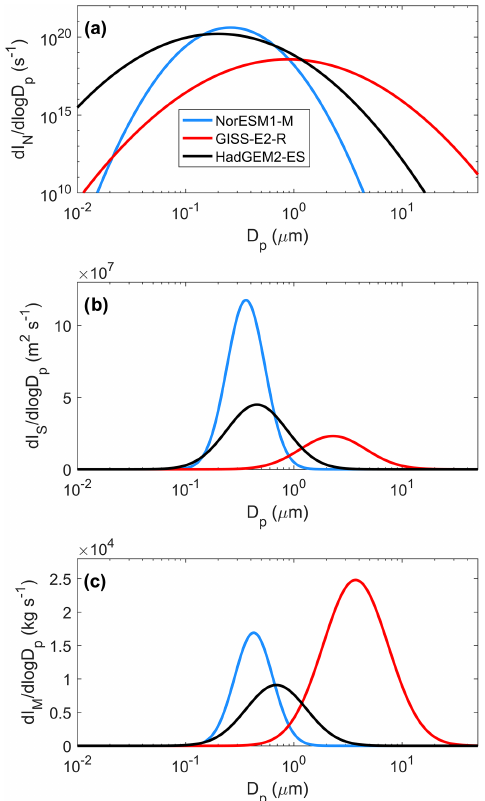
Figure 1. Size distributions for total sea salt injections (30 ◦ N and 30 ◦ S) of (a) particle number I N , (b) particle surface area I S , and (c) particle mass I M for NorESM1-M (blue), GISS-E2-R (red), and HadGEM2-ES